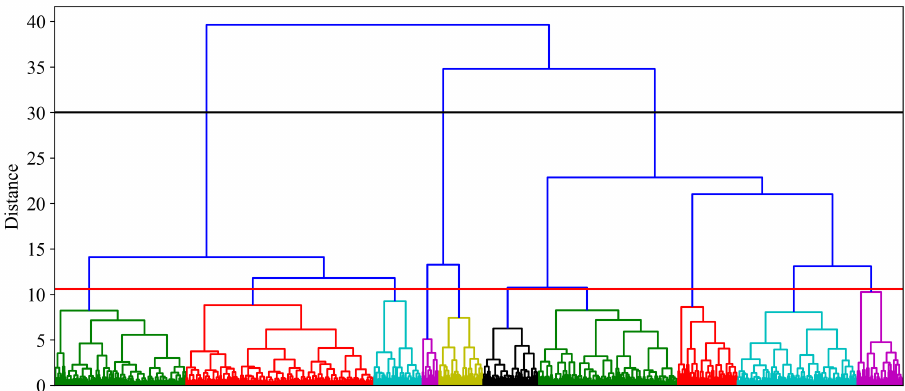
Figure 7. Dendrogram obtained via hierarchical clustering, with a color threshold highlighting 10 clusters. Individual profiles are given on the x-axis, while the y-axis denotes the distance.